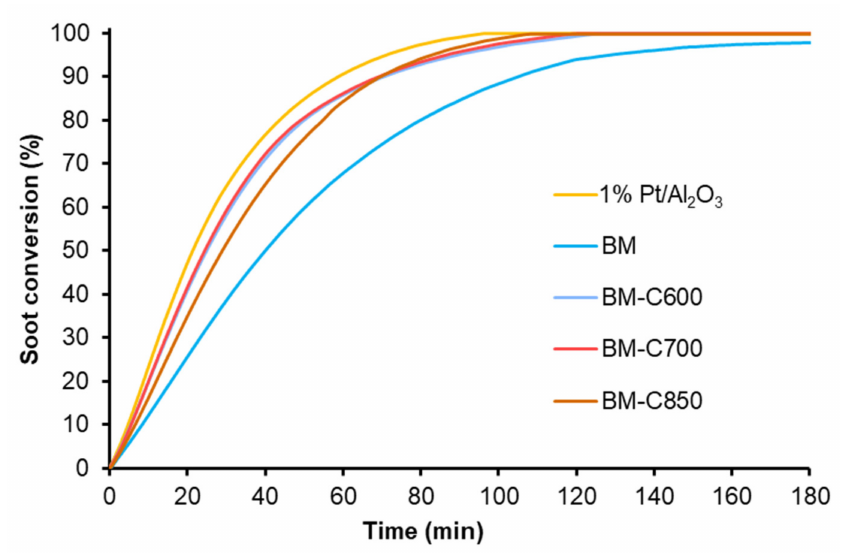
Figure 14. Soot conversion profiles at 450 ◦ C of BM-CX series, and references (1% Pt/Al 2 O 3 and BM). In general terms, the first isothermal soot oxidation cycle reveals that BM-CX catalysts show a higher catalytic activity at 450 ◦ C than BM since BM is not able to totally remove the initial amount of soot after 180 min, while BM-CX samples require over 100 min to remove the 100% of the initial soot. The initial soot oxidation rates were calculated from the slope of soot conversion profiles during the first 20 min of the experiment and the values are included in Table 3, besides the CO 2 selectivity. BM-CX catalysts present a higher initial soot oxidation rate than the BM reference, which is close to the observed for the platinum-based catalyst. Table 3. Initial soot oxidation rates at 450 ◦ C and CO 2 selectivity of BM-CX series, and references.